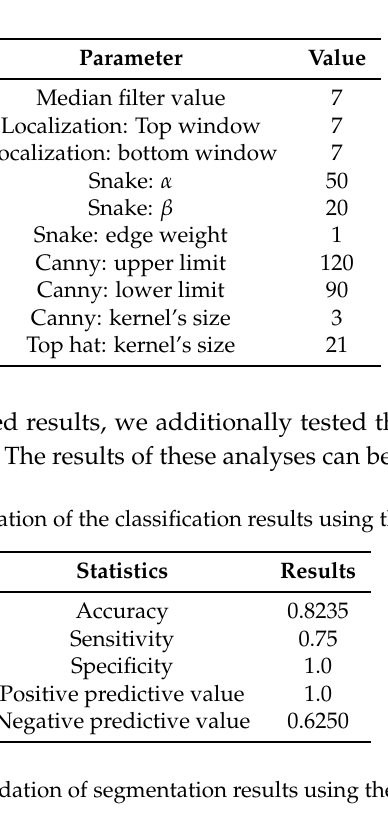
Table 1. Optimal values that were reached by the evolutionary differential evolution (DE) method and used in the validation stage.